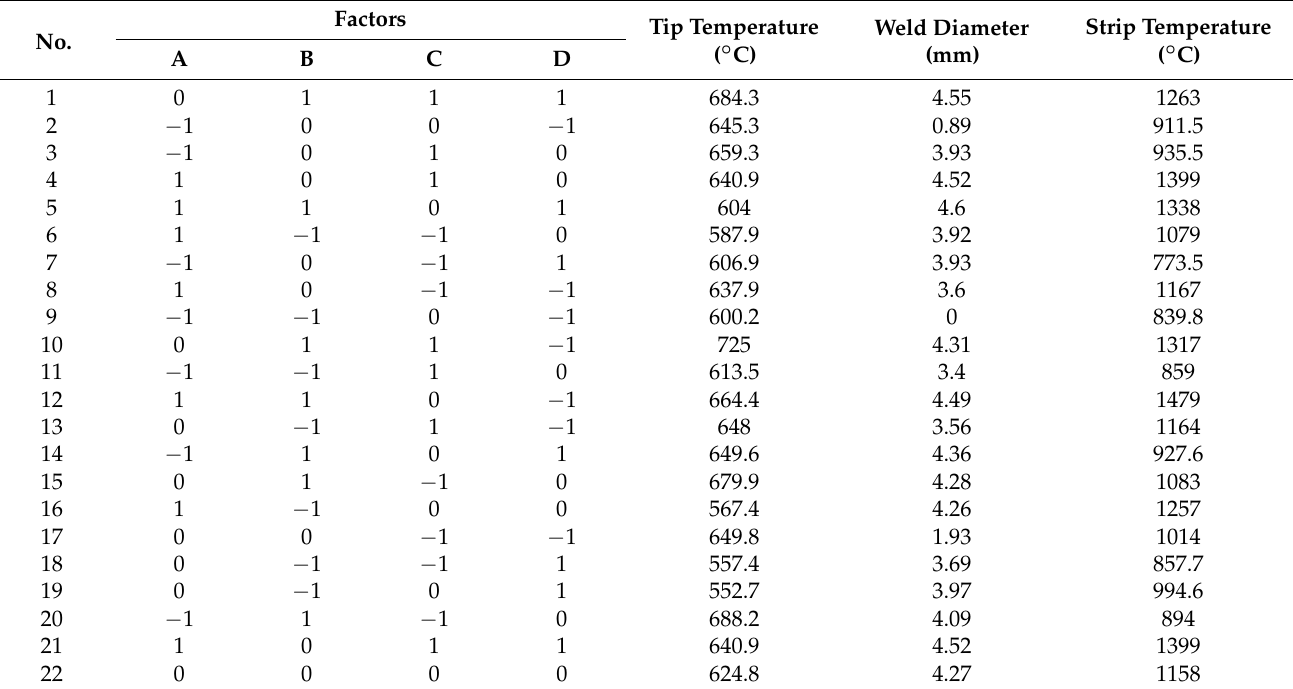
Table 3. Design matrix and